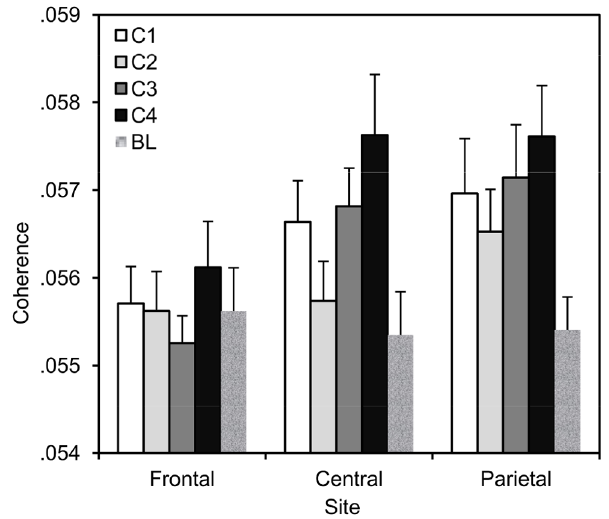
Figure 2. Power effects. Task-related EEG power, averaged over sites, in the beta, gamma and higher gamma frequency bands as a function of competition (C1: cooperative, C2: competitive against computer, C3: competitive with computer, C4: against one another) with baseline (BL) subtracted from each condition. Error bars indicate SE between subjects.